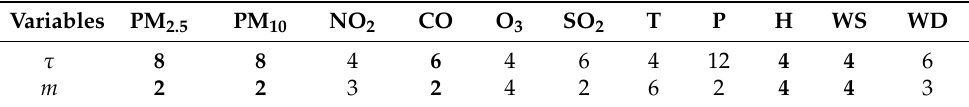
Table 1. Phase space reconstruction parameters of variables. Abbreviations: hourly temperature